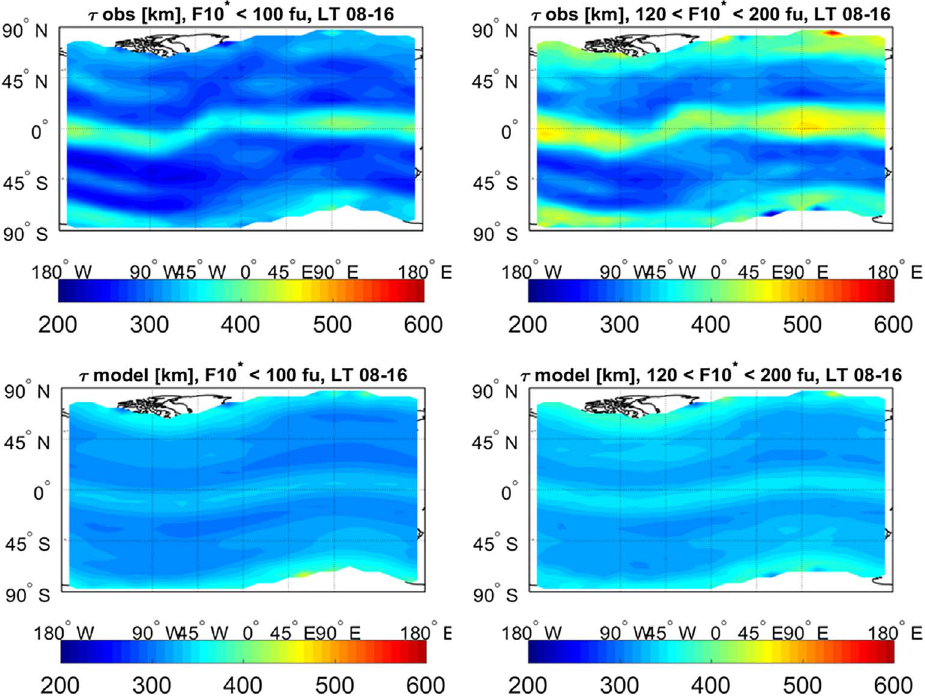
Fig. 7. Daytime (08 – 16 LT) seasonally averaged global maps of observed (upper panels) and modelled s (lower panels) for LSA (left) and HSA (right) conditions.